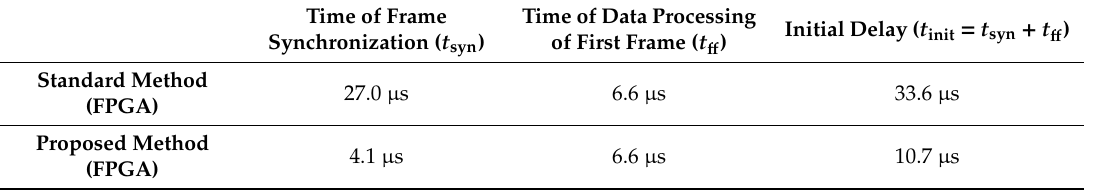
Table 2. The e ff ect of di ff erent methods on the real-time performance of the BOTDA